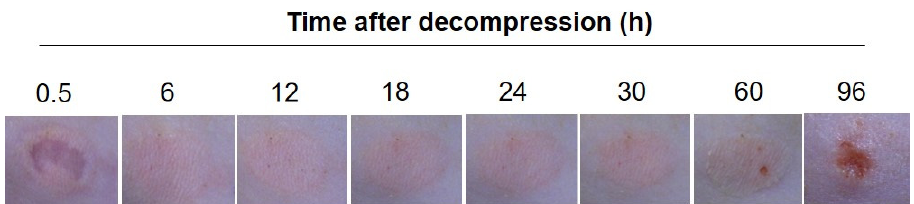
Figure 3. Representative macroscopic observation of the early PI. Macroscopic observations of the loaded area were taken 0.5, 6, 12, 18, 24, 30, 60 and 96 h after decompression. When pressure was applied, non-blanchable erythema was observed at 0.5, 6, 12, 24 and 30 h after decompression, although all instances were alleviated. However, the erythema faded significantly 18 h after decompression (Figure 4).